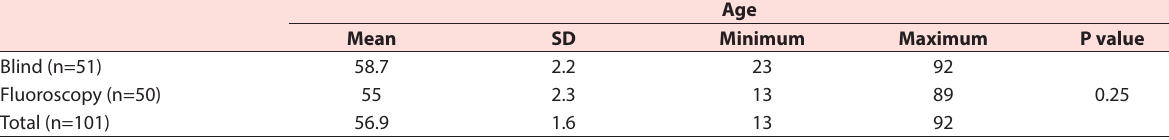
Table 1. Comparison of age between the two groups